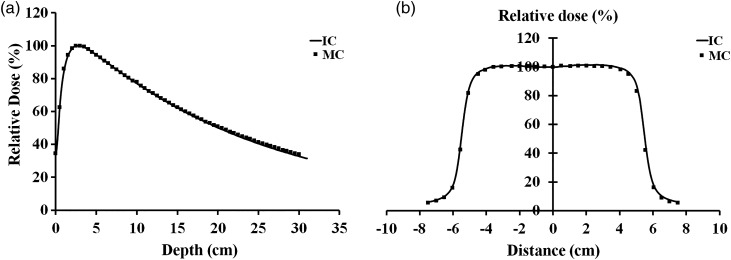
Percentage depth–dose curve and beam profile of 15-MV X-rays compared between Monte Carlo simulation and ionization chamber. (a) PDD opening 10 × 10 cm2 field size. (b) Beam profile opening 10 × 10 cm2 at 10 cm depth.